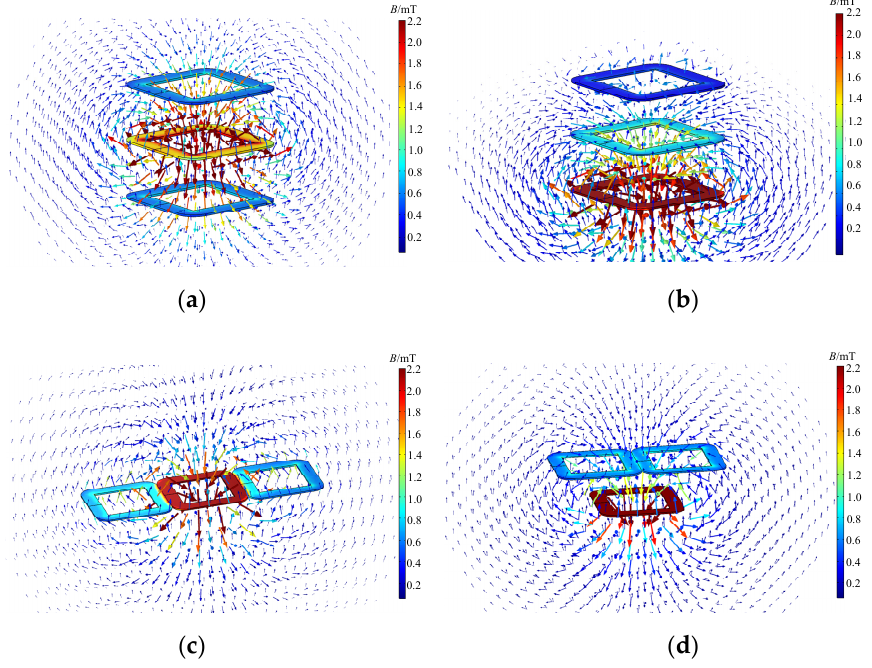
Figure 5. Four simulation models of wireless energy transmission. ( a ) Coaxial opposite side. (b ) Coaxial same side. ( c ) Different axis same side. ( d ) Different axis coplanar.